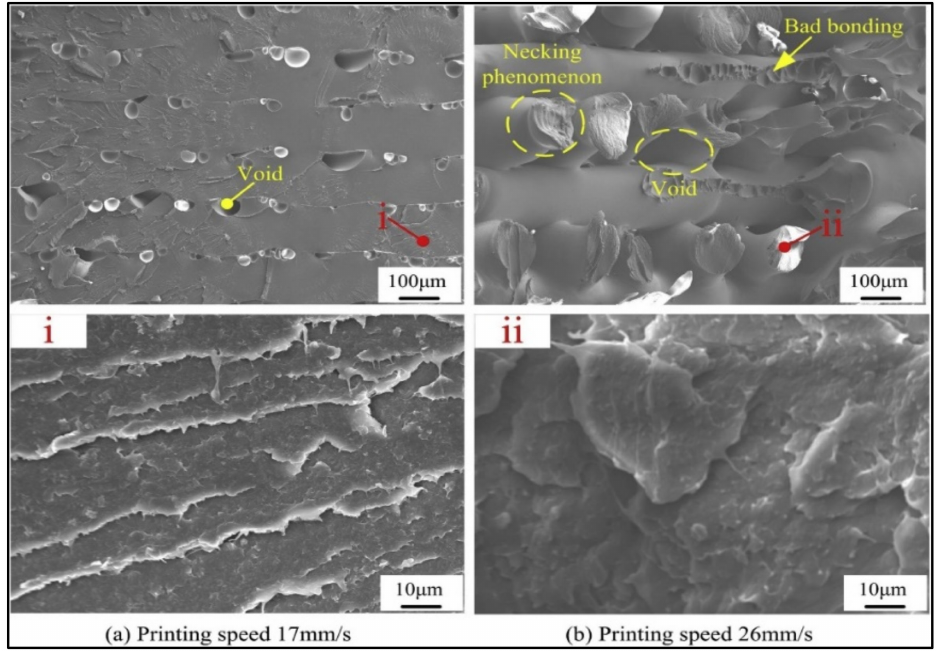
Figure 3. SEM micrographs of tensile fracture surfaces of PEEK samples printed under different speeds ( a ) at 17 mm/s and ( b ) at 26 mm/s (reprinted with permission from